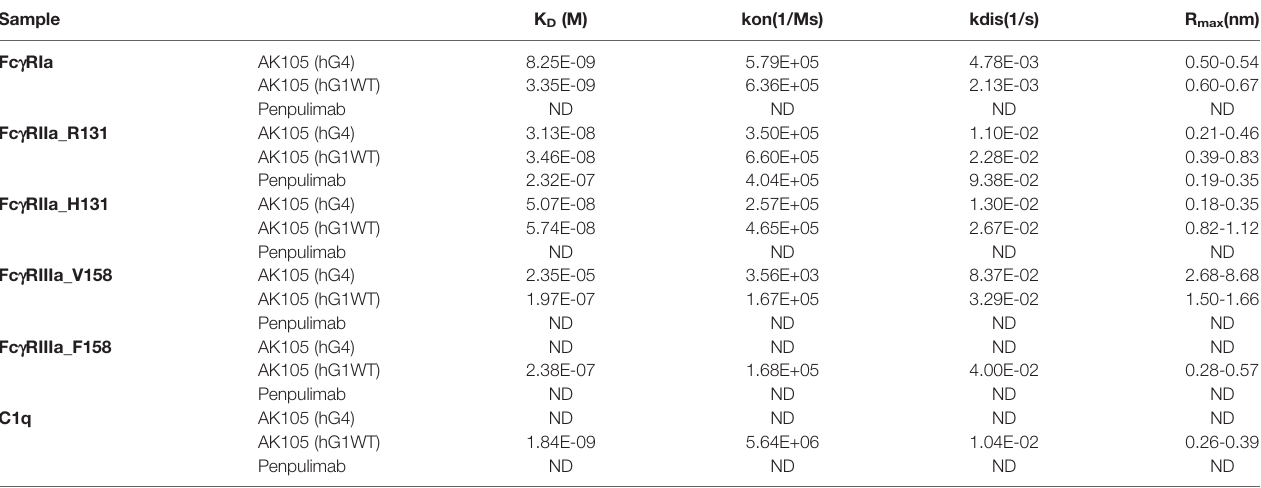
TABLE 1 | Af fi nity of penpulimab for Fc g RIa, Fc g RIIa_R131, Fc g RIIa_H131, Fc g RIIIa_V158, Fc g RIIIa_F158 and C1q. Sample